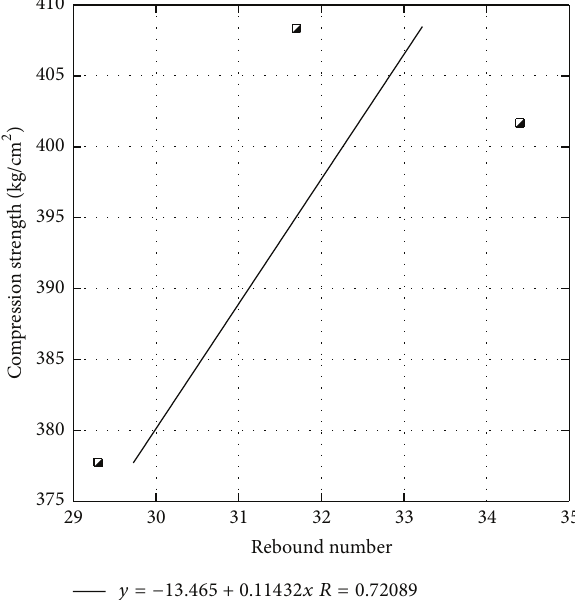
Figure 10: Correlation between UPV and compression strength for train C/D.